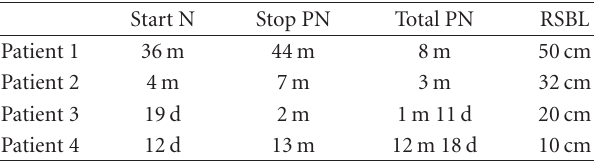
Table 1: Shows for every patient the residual small bowel length (RSBL = residual length of the small intestine measured perop- eratively along the antimesenteric border), the age at the start of Neocate (N), the age of complete PN, weaning and the total time on PN. In all patients the ileocaecal valve and colon were present. m = months; d =